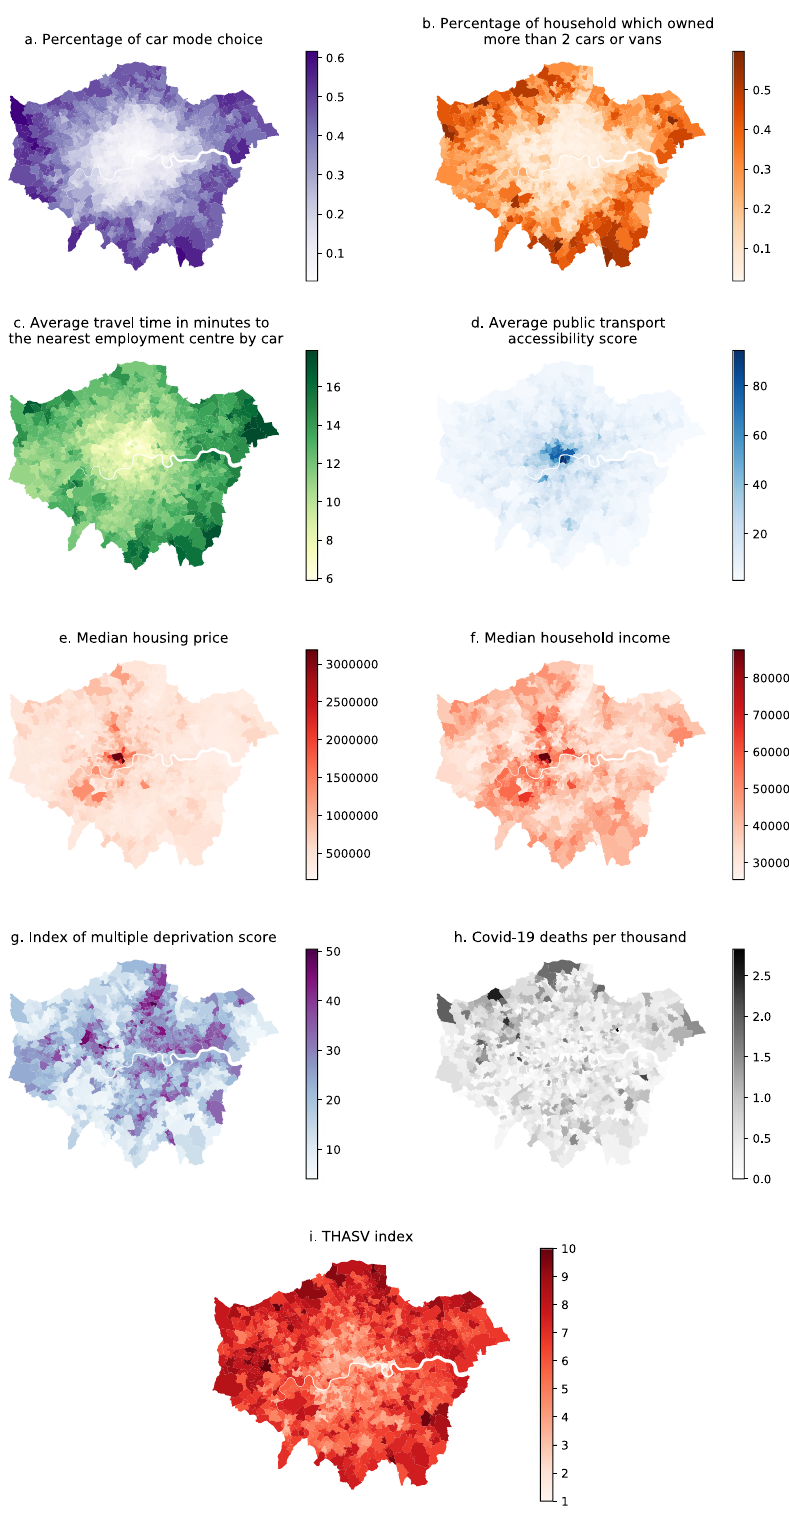
Fig. 2 Choropleth map for each indicator and composite THASV